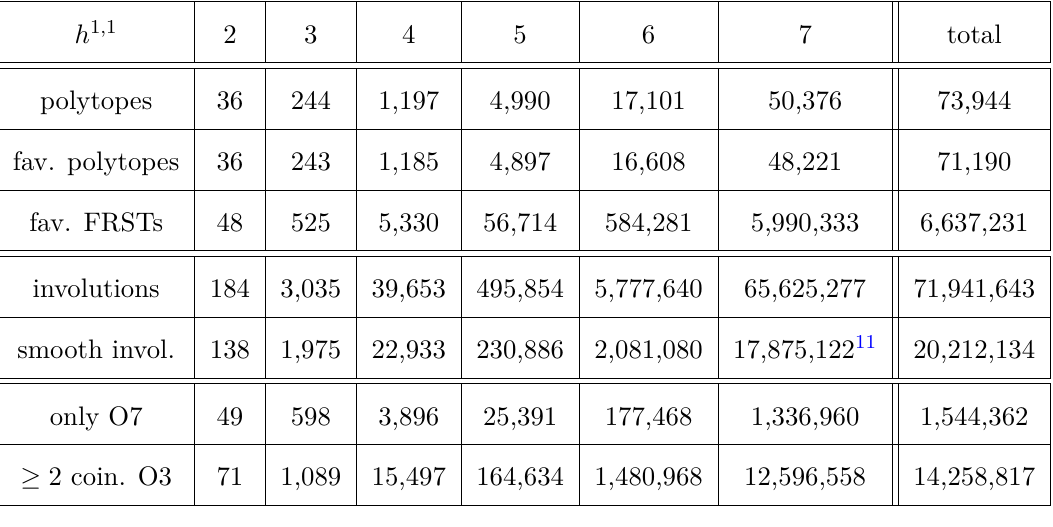
Table 2 . Number of CY orientifolds obtained in our scan. We also collected the numbers of the models with only O7-planes or more than one coincident